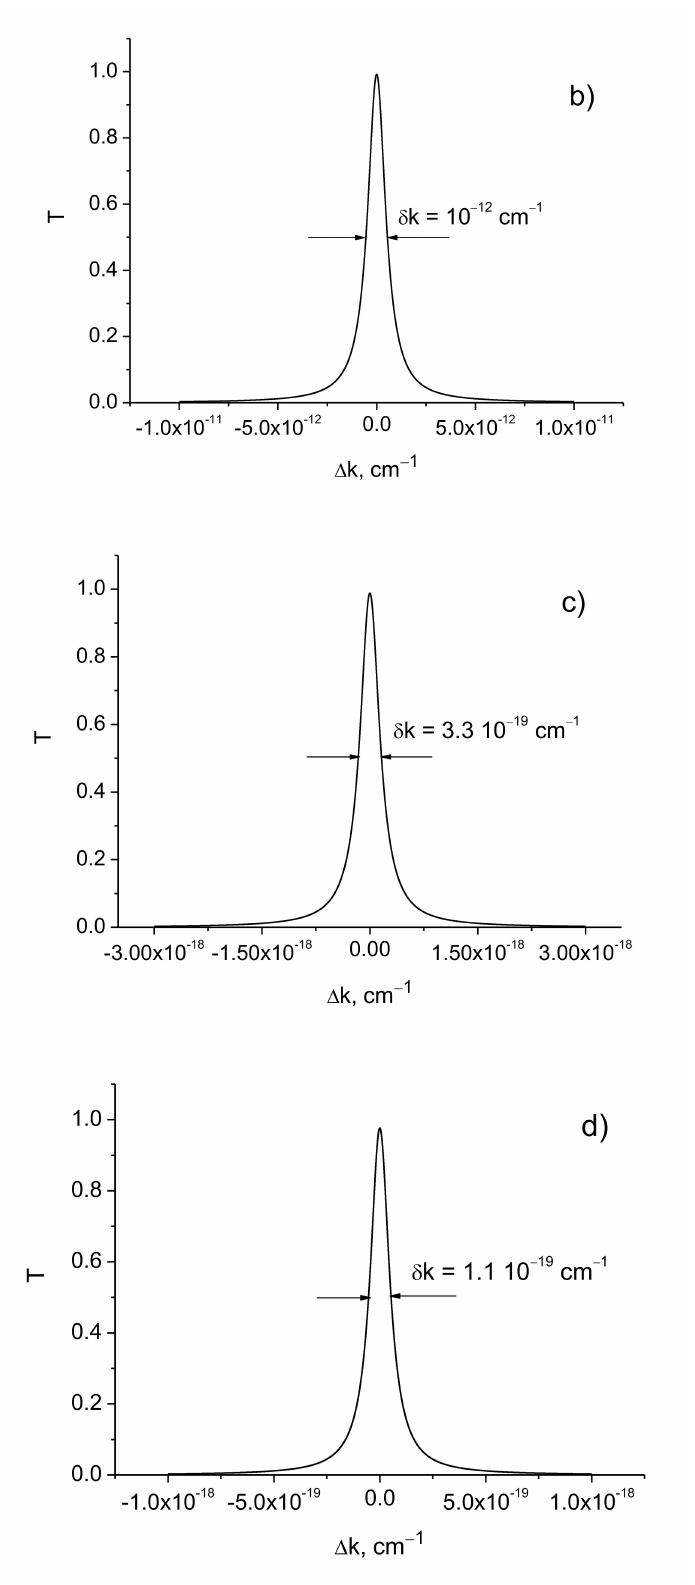
Figure 4. Transmission coefficients as function of the detuning of the resonator. λ = 630 nm, L = 0.40 cm. ( a ) ∆ ε = 3.0 · 10 − 4 , d = 1 m; ( b ) ∆ ε = 3.0 · 10 − 4 , d = 3 m; ( c ) ∆ ε = 5.0 · 10 − 4 , d = 1 m; ( d ) ∆ ε = 5.0 · 10 − 4 , d = 3